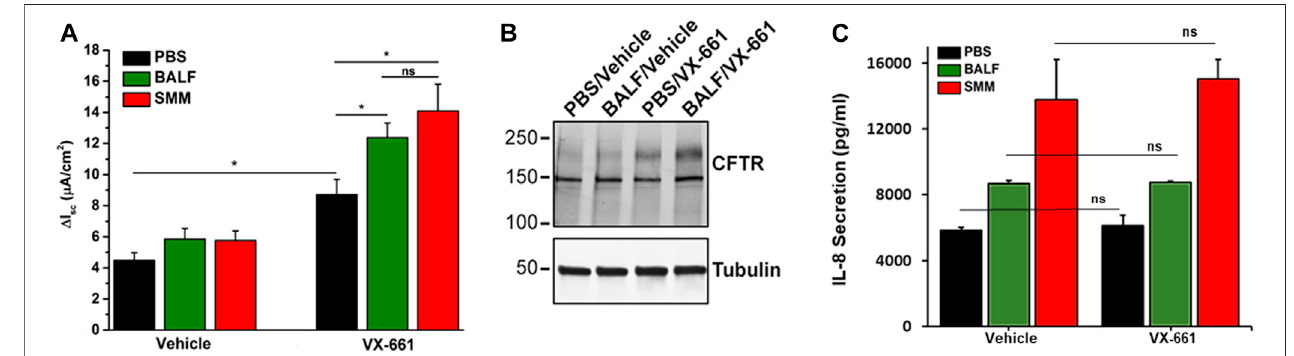
FIGURE 1 | SMM and BALF enhance F508del rescue by VX-661. (A) CFTR responses from F508del/F508del HBE evaluated in Ussing chambers. Cultures were exposedapicallyto30 µMSMMorBALFandtreatedonthebasolateralsidewithvehicleor5 µMVX-661,asdescribedinMethods.Dataareexpressedasmean ± SEM. * p < 0.05,(ttests),ns (cid:2) notsigni fi cant;n (cid:2) 2donors, fi vetosixcultures/experimentalgroup. (B) RepresentativeCFTRWesternblottoanalyzeF508delmaturation(upper band); n (cid:2) 2 cultures due to limited amounts of BALF. (C) IL-8 secretion (pg/ml of culture media) from the F508del/F508del HBE evaluated in (A) . Data are expressed as mean ± SEM. Note: Because the BALF samples were diluted, they were concentrated 4-fold with Centricon centrifugal fi lter